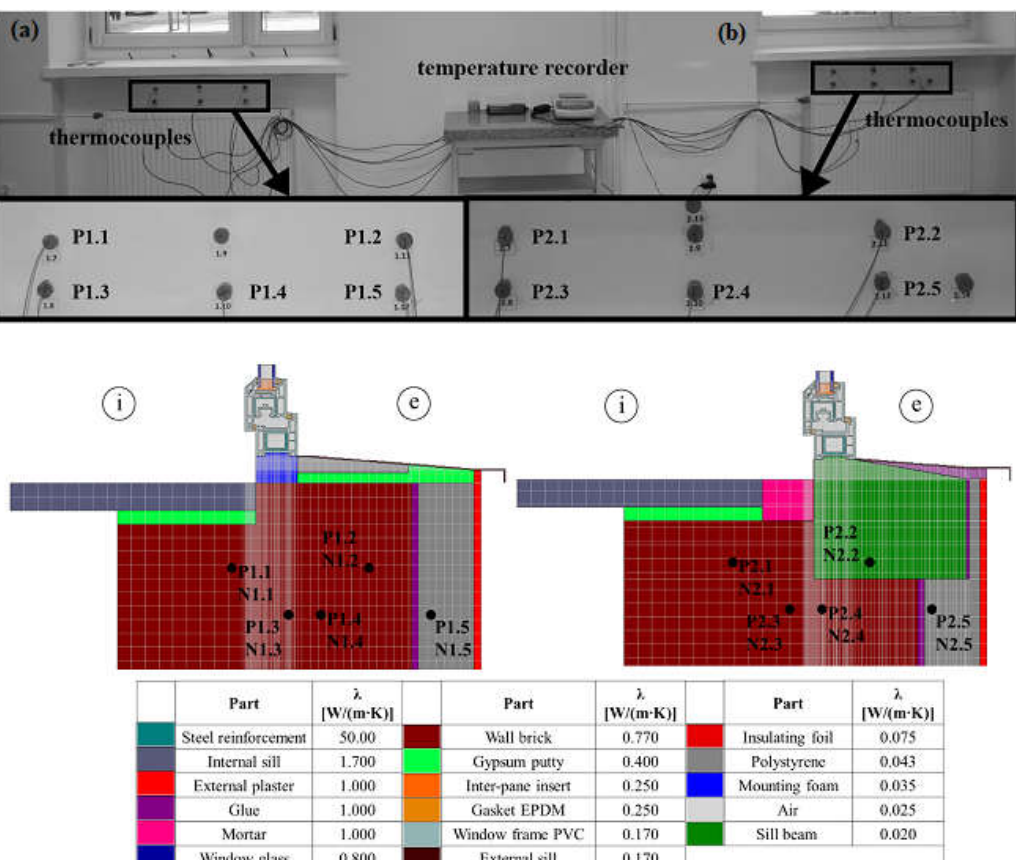
Figure 3. Test stand and numerical models for bottom sections of windows installed in ( a ) a conventional way and ( b ) using a composite frame: P1.1 ÷ 5 and P2.1 ÷ 5—measurement points in wall, N1.1 ÷ −5 and N2.1 ÷ −5—corresponding numerical nodes (i—internal, e—external).